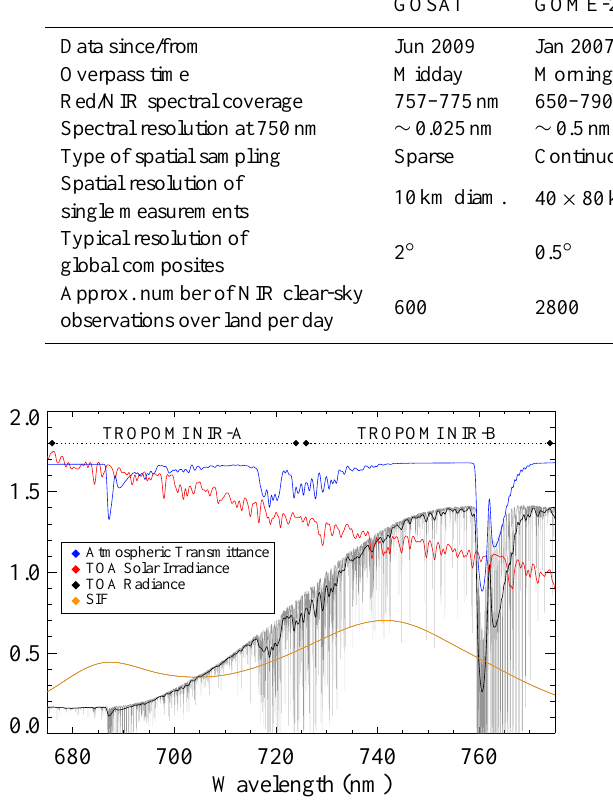
Figure 1. Normalized spectra of sun-induced fluorescence (SIF), at- mospheric transmittance, solar irradiance at the top-of-atmosphere Fig. 1: Normalized spectra of sun-induced fluorescence (TOA) and TOA radiance from a green vegetation target. The spec- (SIF), atmospheric transmittance, solar irradiance at the top- tra are presented at the 0.1nm spectral sampling and 0.5nm reso- of-atmosphere (TOA) and TOA radiance from a green vege- lution of TROPOMI. The TOA radiance spectrum is also plotted at tation target. The spectra are presented at the 0.1 nm spectral 0.005nm resolution (grey sampling and 0.5 nm resolution of TROPOMI. The TOA ra- diance spectrum is also plotted at the 0.005 nm input resolu- tion (grey shade).